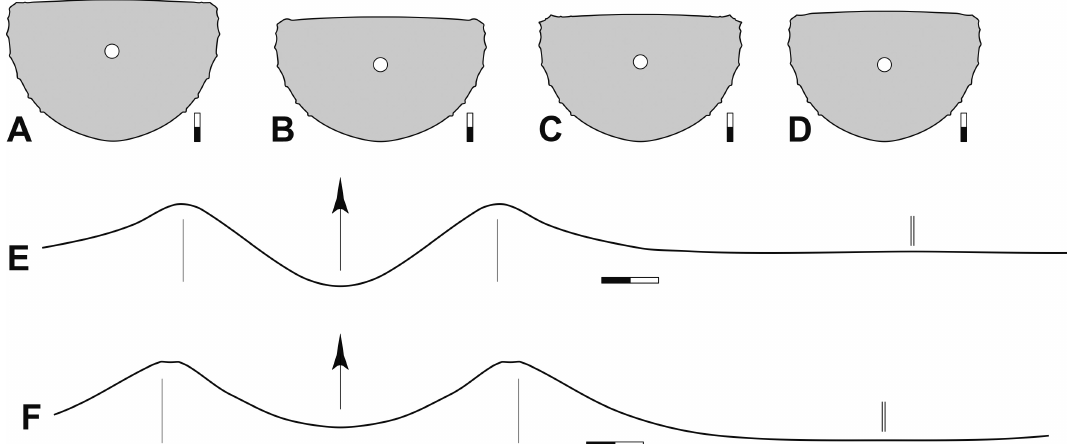
Fig. 7. Stroborineceras insalahensis gen. et sp. nov. from Oued Temertasset (all Korn et al . 2002 Coll.). A . Whorl profile of holotype MB.C.30445.1. B . Whorl profile of paratype MB.C.30446.1. C . Whorl